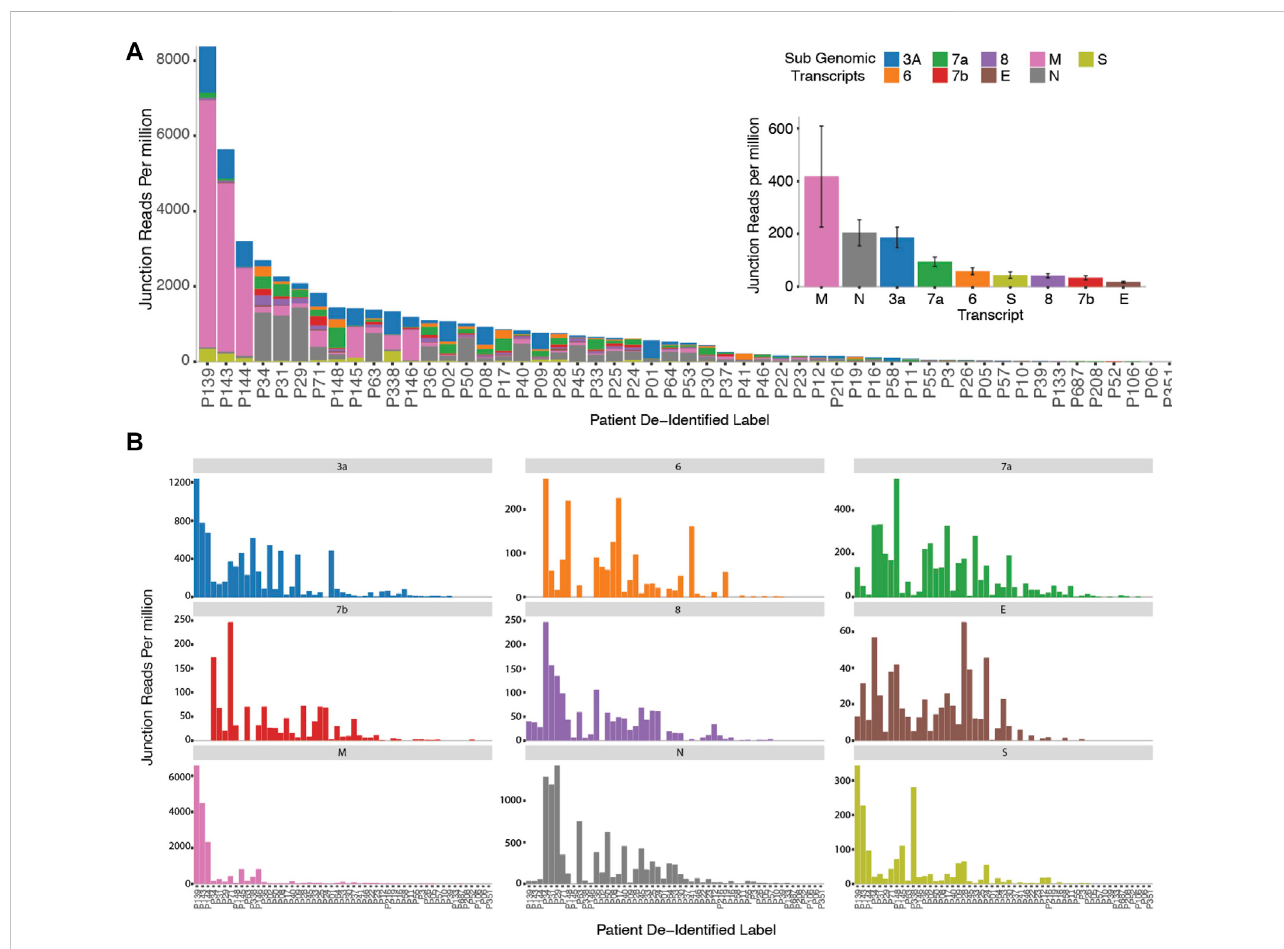
FIGURE 2 Cohort wide identi fi cation of subgenomic Reads. (A) Stacked bar graphs re fl ecting the amount of normalized sub genomic gappedreads for each of the nine canonical subgenomic transcripts across our patient cohort. (Inset) Distribution of total reads per canonical transcript across the patient cohort. (B) Distribution of normalized individual subgenomic gapped read counts across the patient